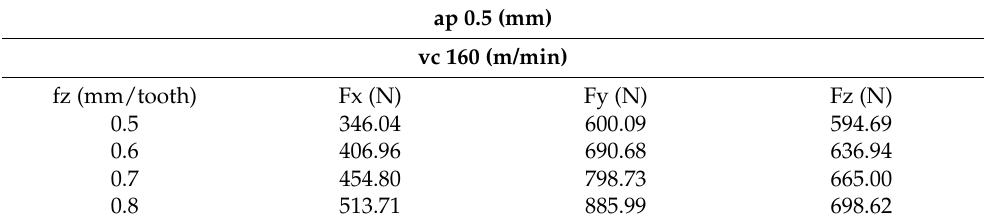
Table 5. Average value of cutting force in terms of dependence on